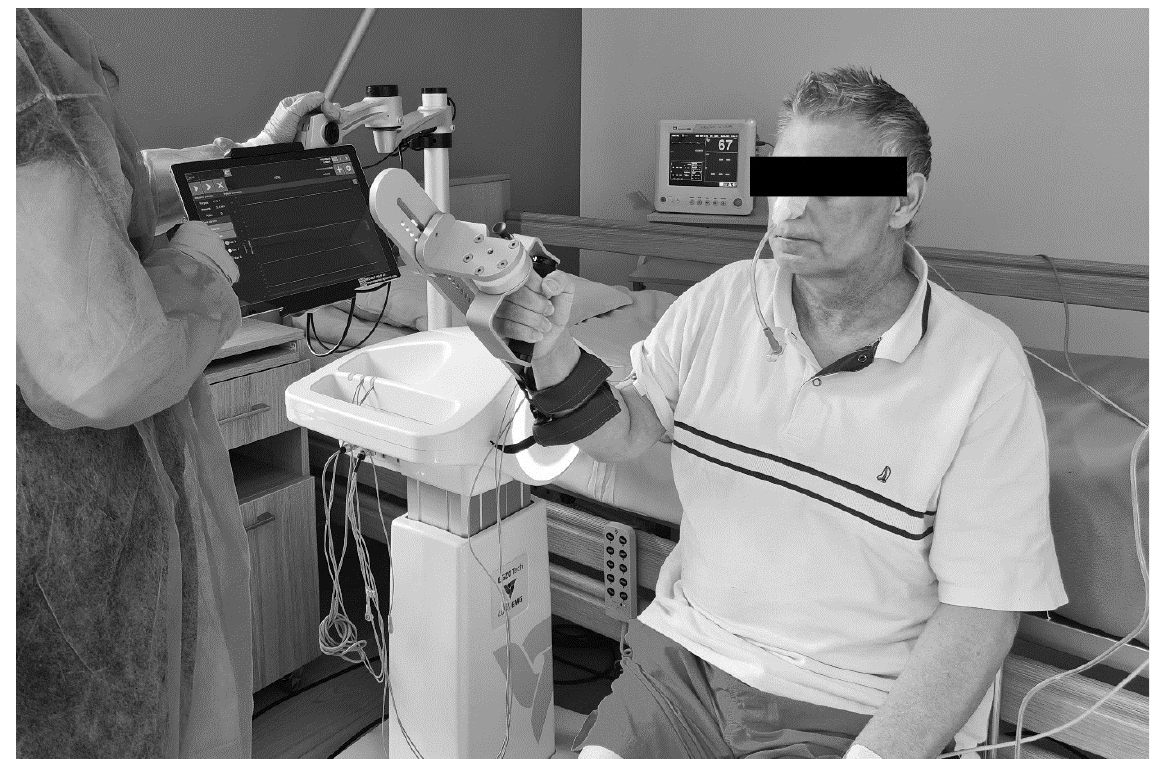
Figure 1. An example of the EMG robot setup during the exercises (source: authors’ own).